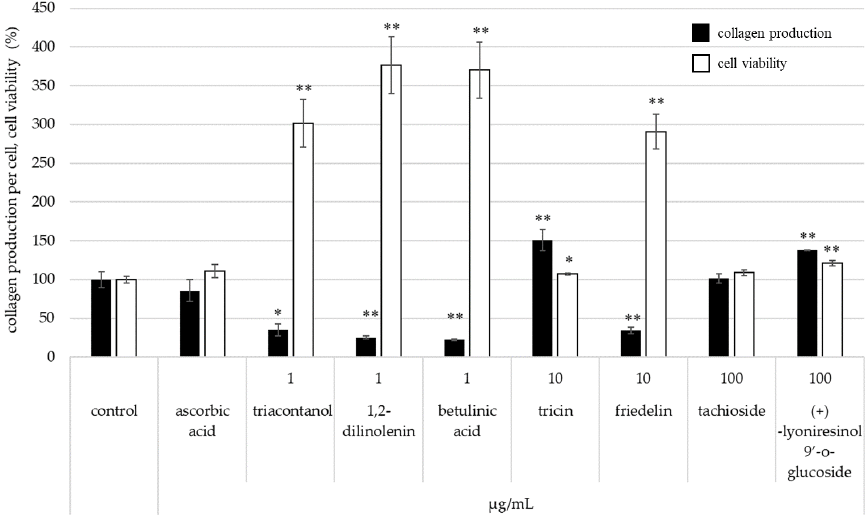
Figure 8. Effect of isolated compounds on the production of collagen (* p < 0.05 and ** p < 0.01).